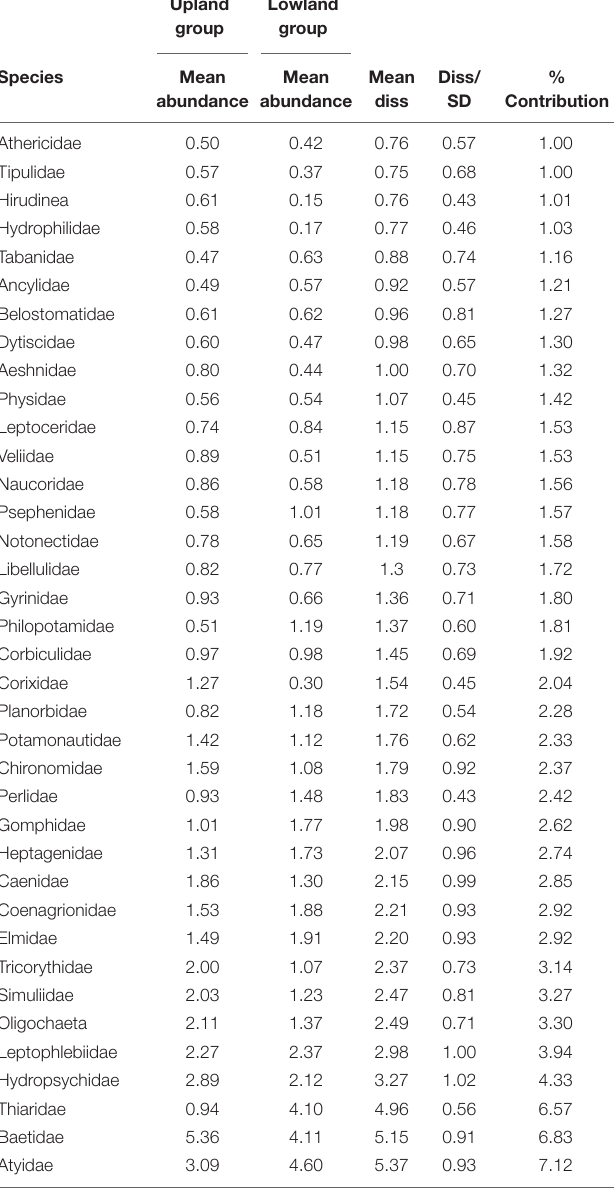
TABLE 1 | Dissimilarities in macroinvertebrate taxa between upland and lowland rivers of KwaZulu-Natal, South Africa, from 2015 to 2016. Upland Lowland group group